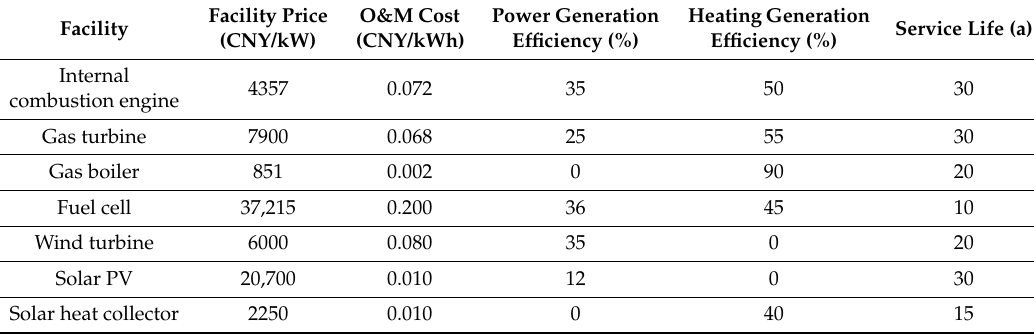
Table 1. Parameters of energy supply facility